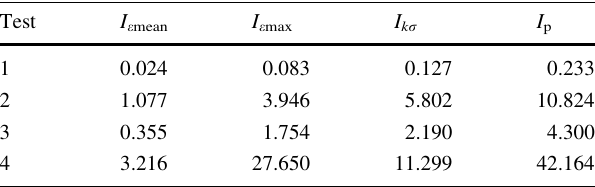
Table 4 Consistency evaluation of the short-circuit currents in Sys- tem A (%)